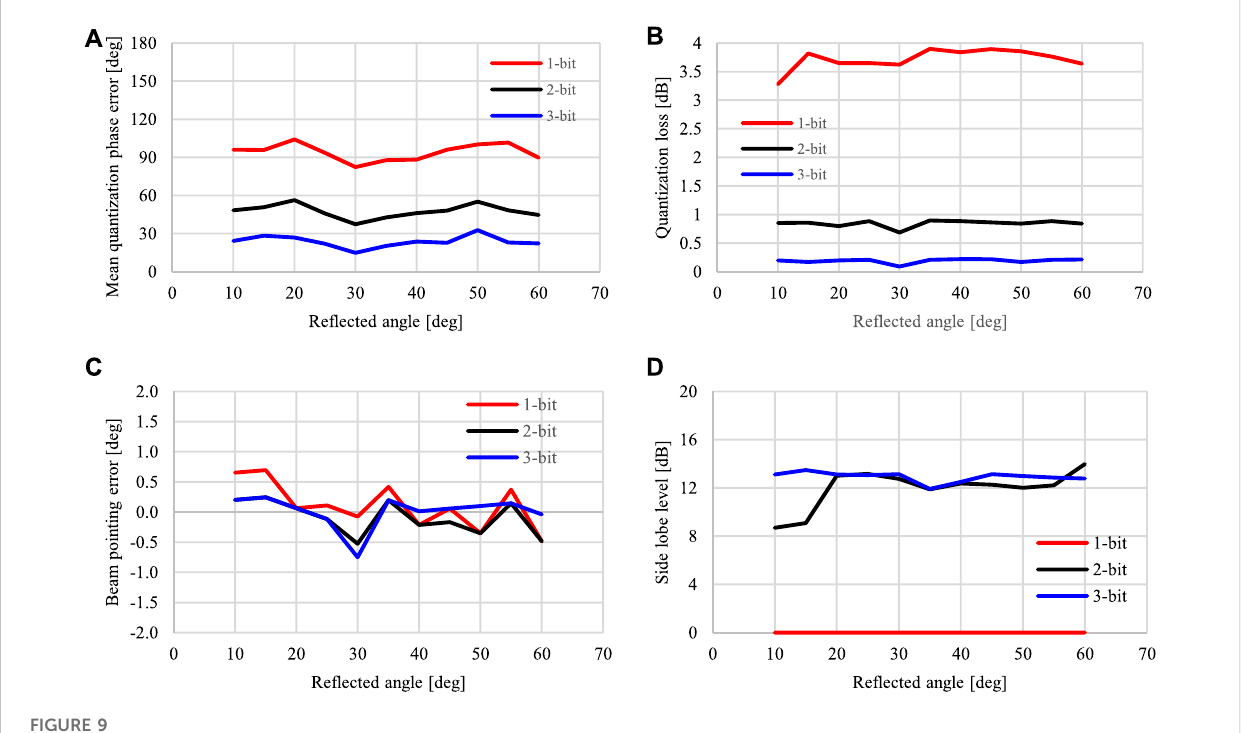
FIGURE 9 RIS array factor performance for different quantization bits. (A) Mean quantization phase error. (B) Quantization loss. (C) Beam pointing error. (D) Side lobe level.